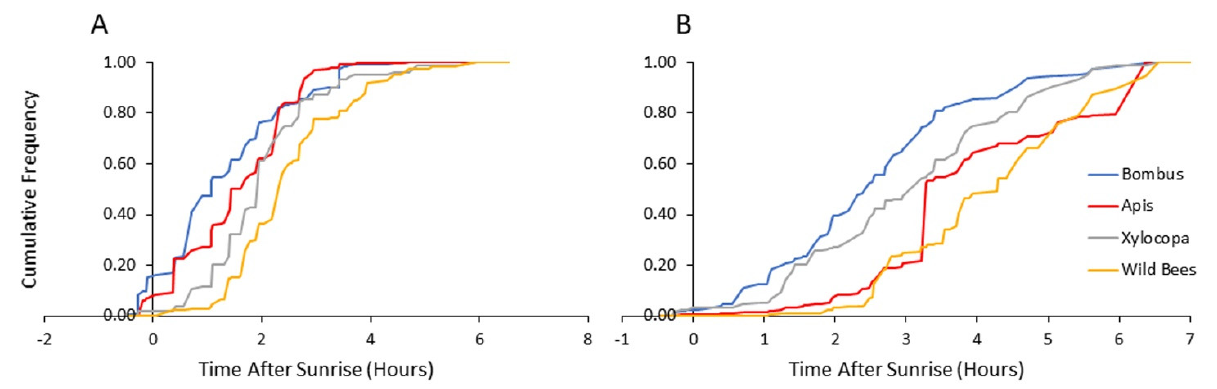
Figure 5. Flower visitation of bees from each category as a function of time after sunrise: ( A ) visita- tions to pollen-providing flowers and ( B ) visitations to nectar-providing flowers. The vertical axis presents the cumulative frequency of bee numbers for both 2013 and 2014.